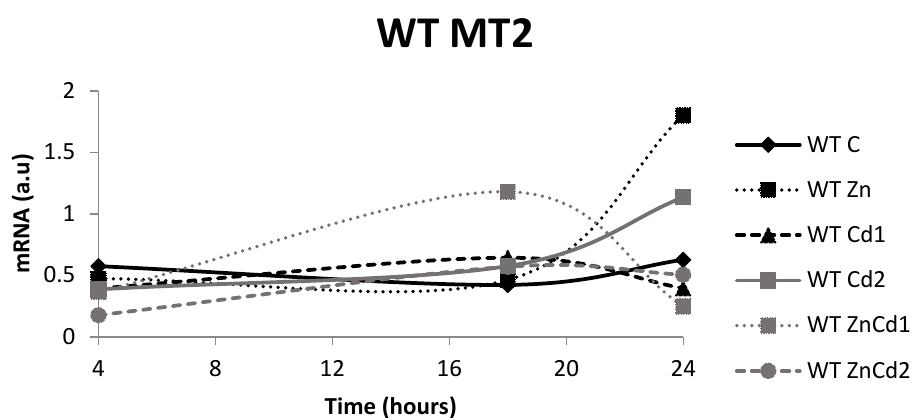
Figure 8. mRNA in arbitrary units (a.u.) of the MT-2 gene in the WT strain. C = Control; Zn = Zn 50 µM; Cd 1 = Cd 1 µM; Cd 2 = Cd 2 µM; ZnCd 1 = Zn 50 µM + Cd 1 µM; ZnCd 2 = Zn 50 µM + Cd 2 µM.